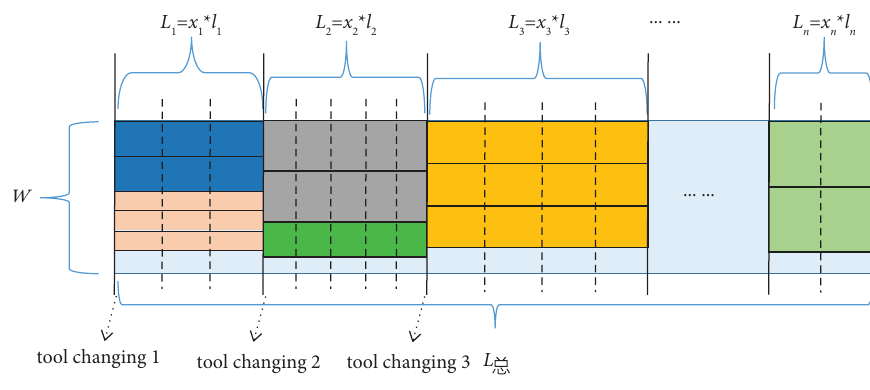
Figure 1: Blank layout